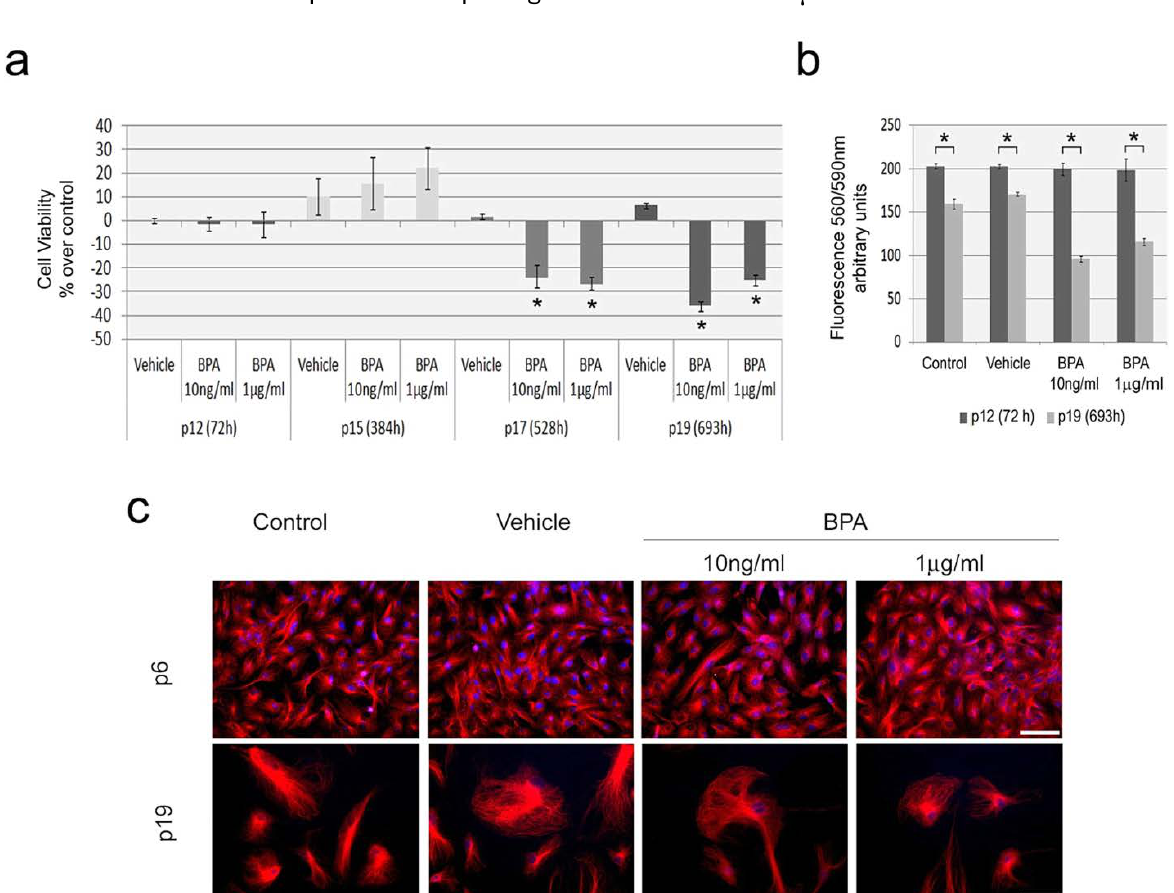
Figure 2. Evaluation of BPA exposure effects on cellular viability and morphology